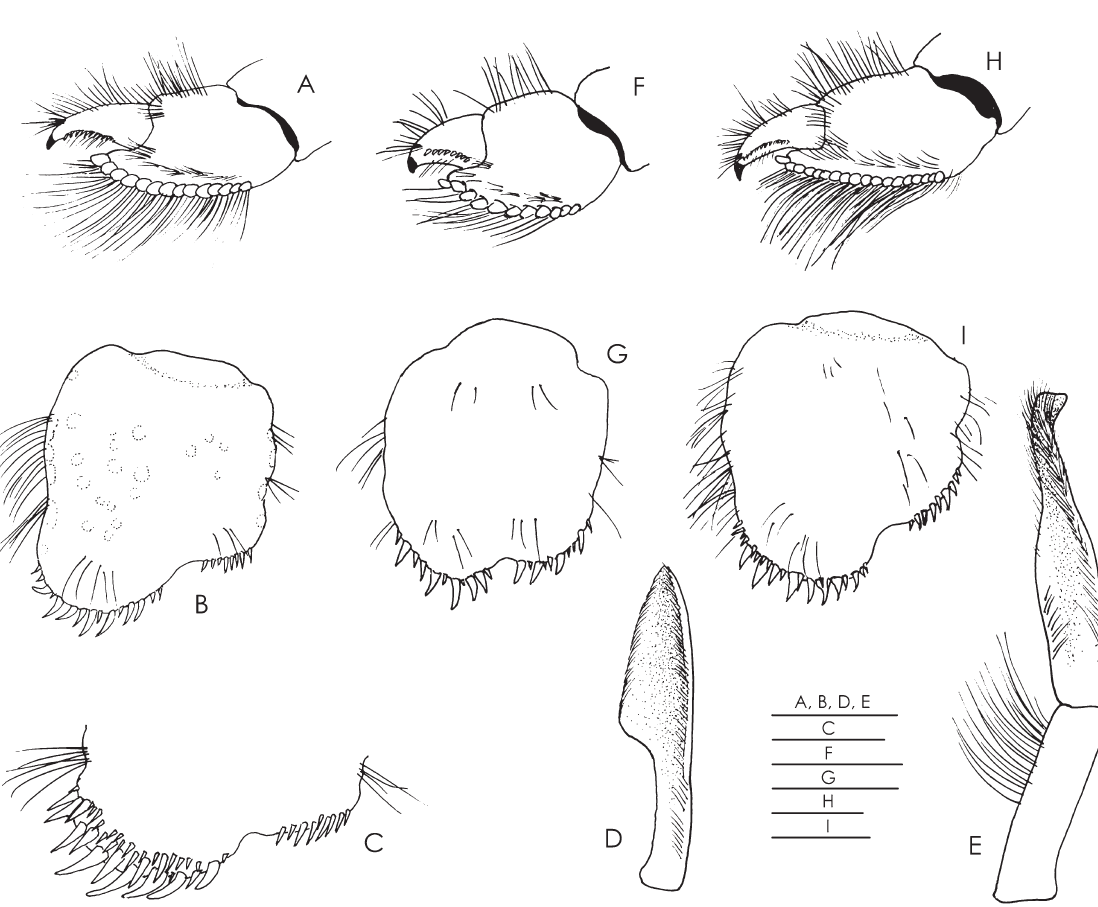
F IG . 5. – Strobopagurus breviacus sp. nov., New Caledonia: A-C, D, E, SMIB 5, stn DW 76, holotype M 6.1 mm (MNHN Pg 7116); C, MUSORSTOM 5, stn DW 258, paratype F 4.8 mm (MNHN Pg 7087). Strobopagurus gracilipes (A. Milne-Edwards, 1891), New Caledo- nia: F, G, BIOCAL, stn DW 33, M 3.7 mm (MNHN Pg 7119). Strobopagurus sibogae (de Saint Laurent, 1972), Indonesia: H, I, “ Siboga ” Expedition, stn 12, holotype ov F 7.4 mm (ZMA De103.109). A, F, H, propodus and dactyl of left fourth pereopod, lateral view; B, G, I, tel- son, dorsal view; C, posterior margin of telson, dorsal view; D, left male first pleopod, mesial view; E, left male second pleopod, anterior view. Scales equal 1 mm (A, B, D, E, F, H, I), and 0.5 mm (C,